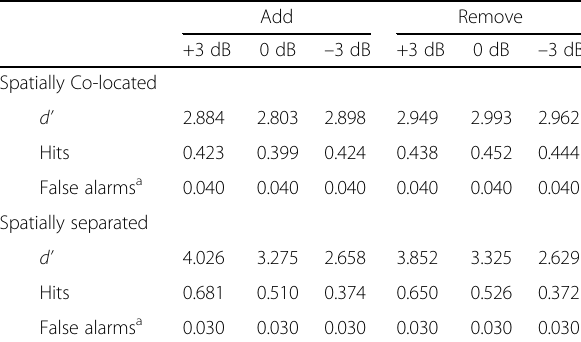
Table 2 Sensitivity ( d ’ ), hits, and false alarms for the change deafness (AX same/different) task. d ’ calculations are based on a differencing model (Macmillan & Creelman,